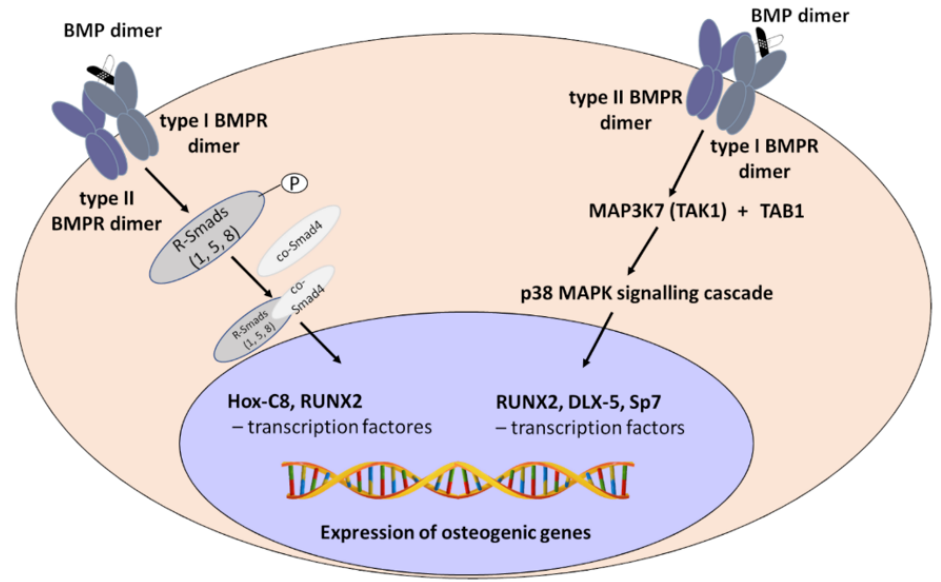
Figure 1. Canonical and non-canonical BMP signalling pathway.